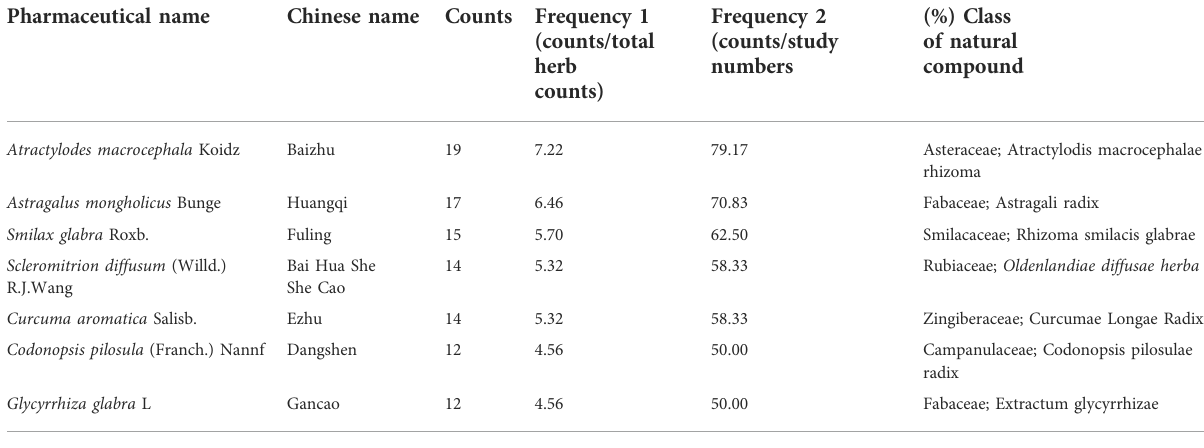
TABLE 3 High-frequency Chinese